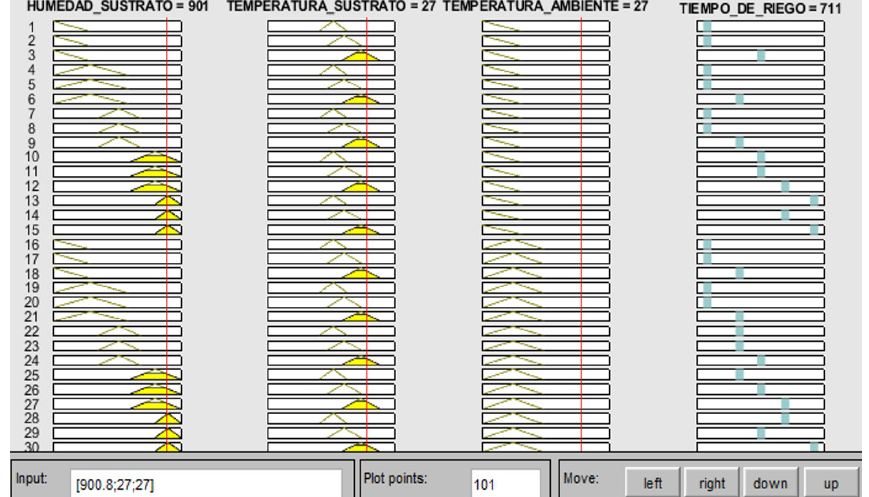
Figure 12. Fuzzy controller 1 results.